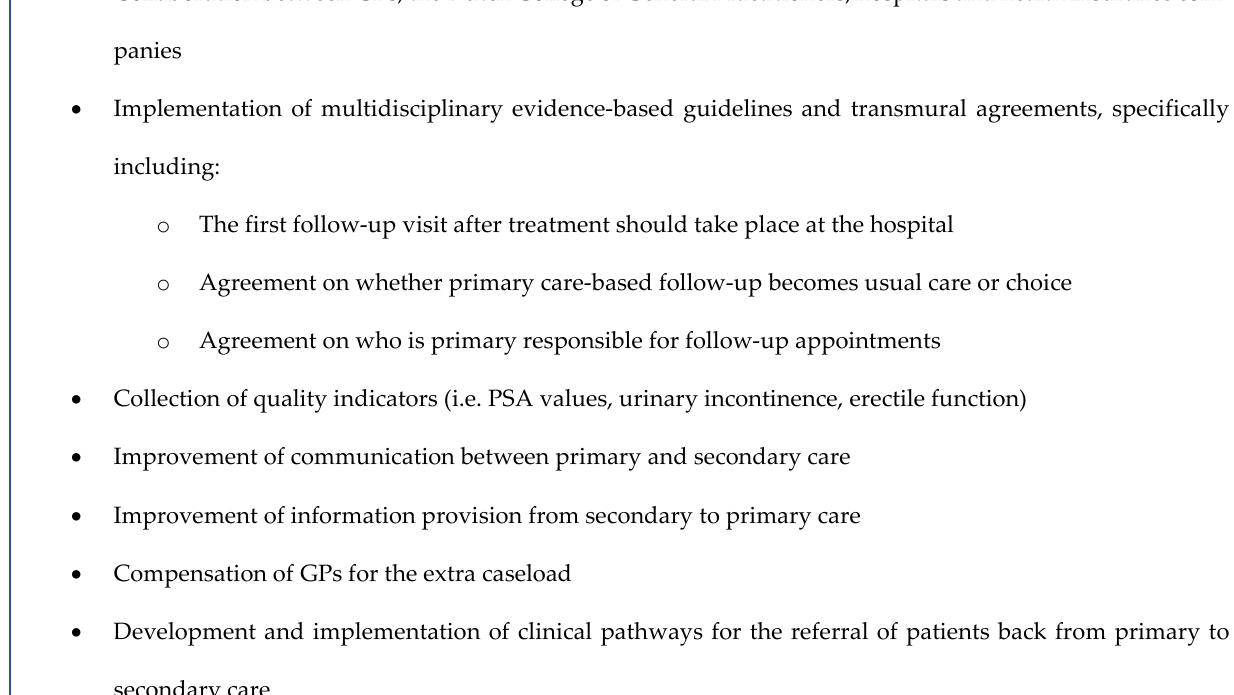
Figure 2. Organizational requirements necessary for the implementation of primary care-based fol- low-up.